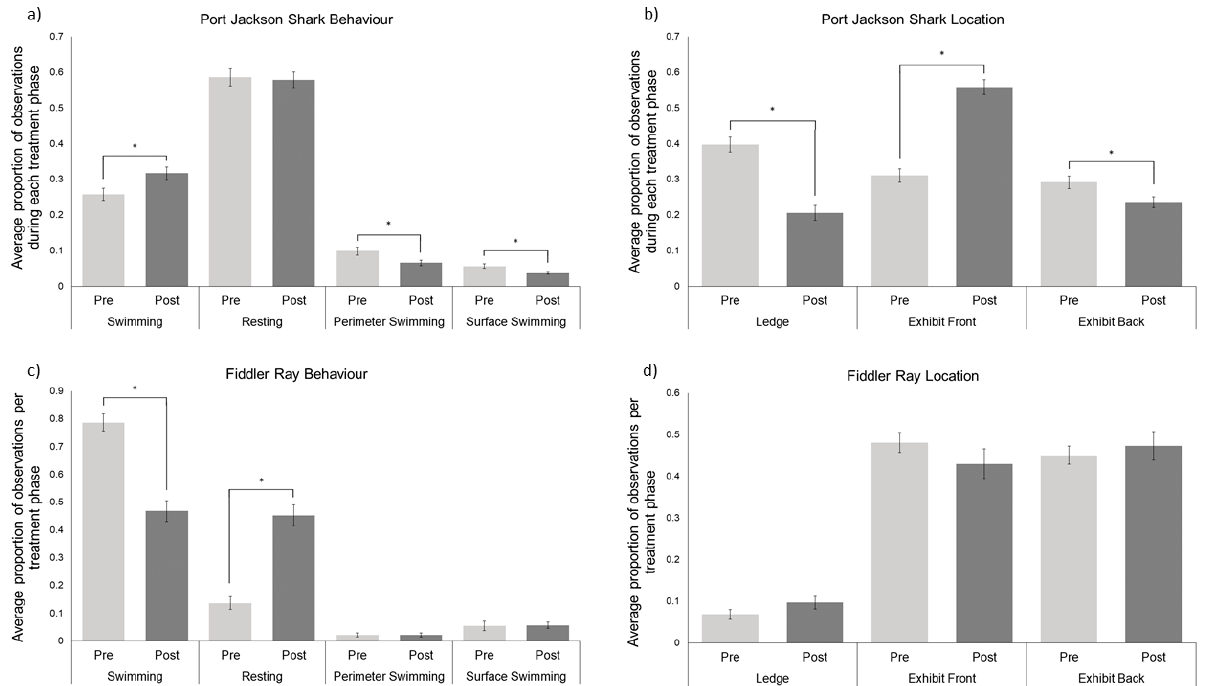
Figure 2. ( a ) The average proportion of time the Port Jackson sharks ( n = 4) spent performing the different behaviours pre ‐ post renovations. ( b ) The average proportion of time the Port Jackson sharks ( n = 4) spent in each exhibit location pre ‐ post renovations. ( c ) The average proportion of time the Southern fiddler ray ( n = 1) spent performing the different behaviours pre ‐ post renovations. ( d ) The average proportion of time the Southern fiddler ray ( n = 1) spent in each exhibit location pre ‐ post renovations. Pre ‐ renovations means are represented by light grey bars and post ‐ renovations are represented by dark grey bars for all panels. The error bars represent the SEM and the * indicate statistically significant differences ( p < 0.05).